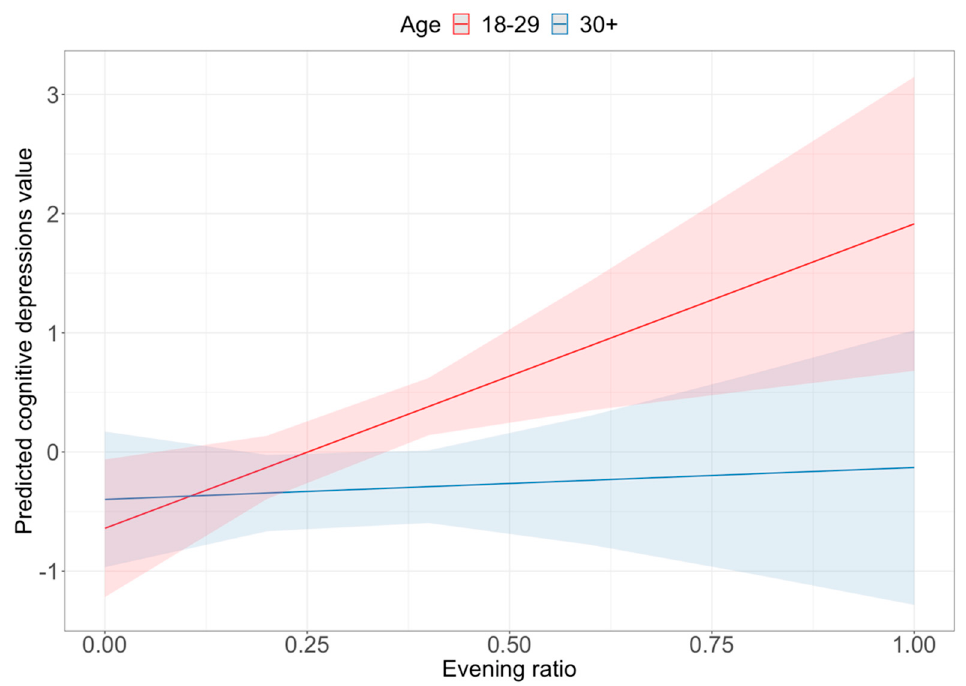
Figure 6. Interaction effect of evening activity ratio and age on cognitive-affective depression (marginal models).